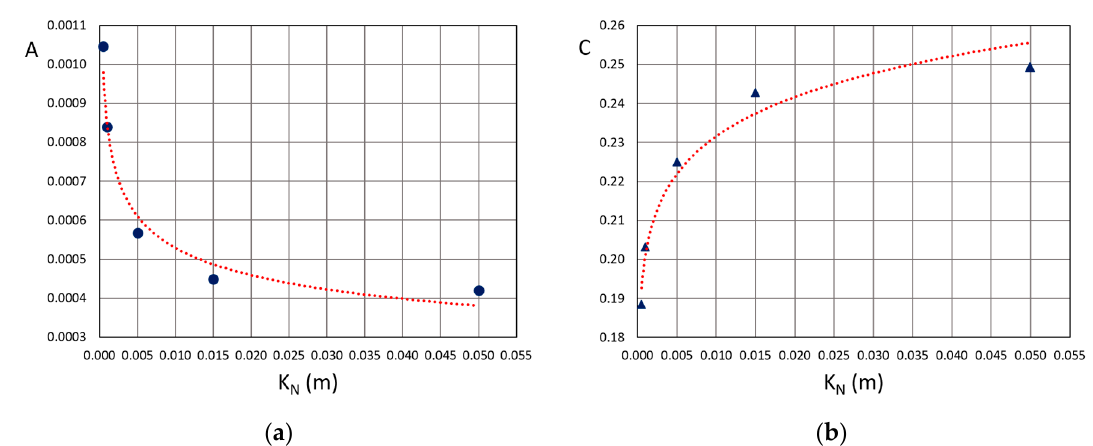
Figure 4. Values of: ( a ) the coefficient A entering in Equation (4) and ( b ) the coefficient C entering in Equation (5), as a function of the equivalent bottom roughness. The dotted lines are the relative regression curves by means of the least squares method.